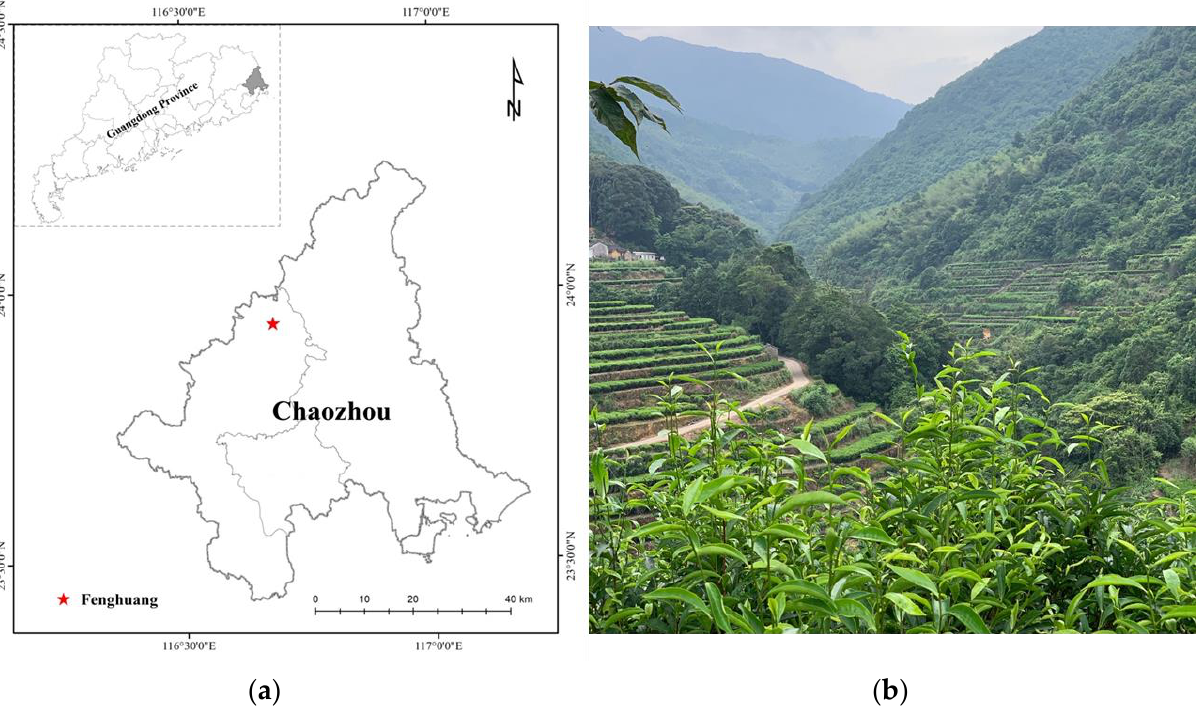
Figure 1. ( a ) Map of the research area in Guangdong, China. ( b ) Tea plantation in Fenghuang. Source: photograph by the first author .